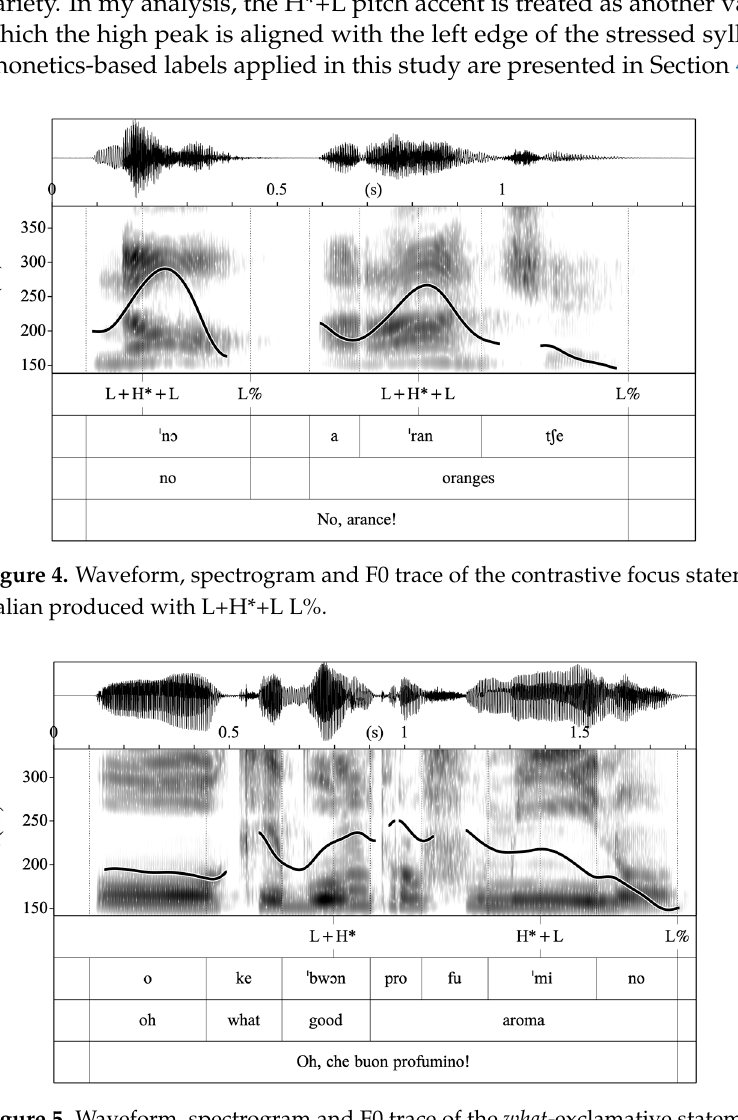
Figure 5. Waveform, spectrogram and F0 trace of the what -exclamative statement What a lovely smell! in L1 Italian produced with H*+L L%.